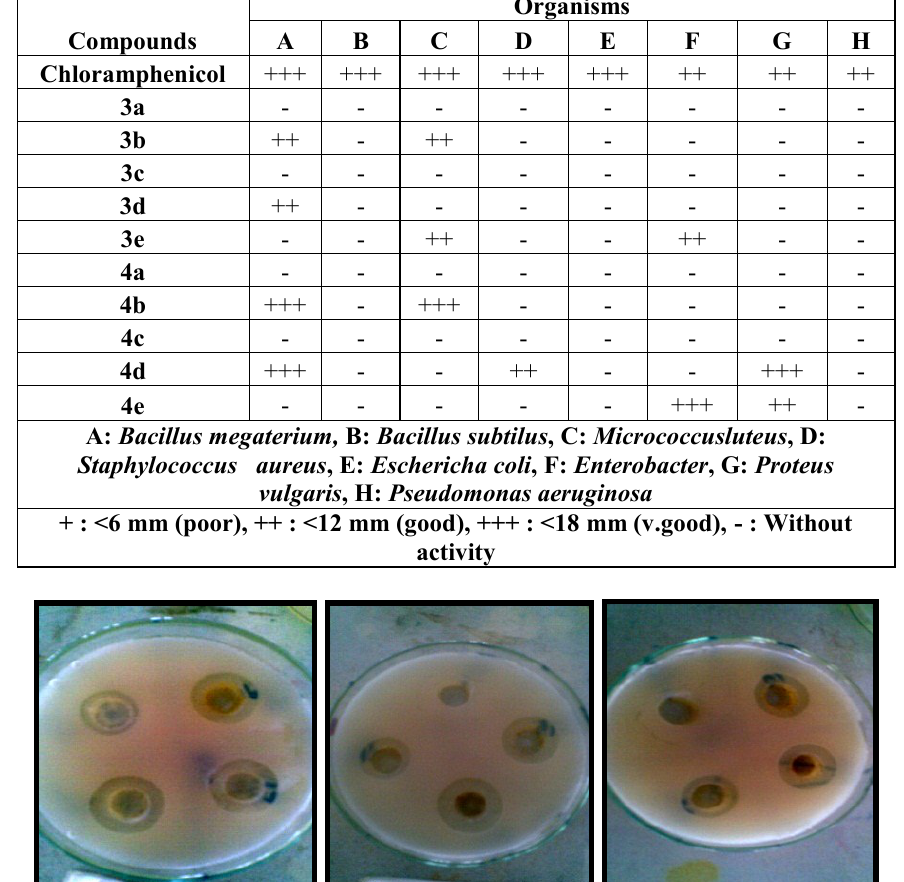
Table 2: Antibacterial activity of Chalcones and Pyrazoline derivatives. Antimicrobial Activity of Synthetic Compound (In mm) Compounds